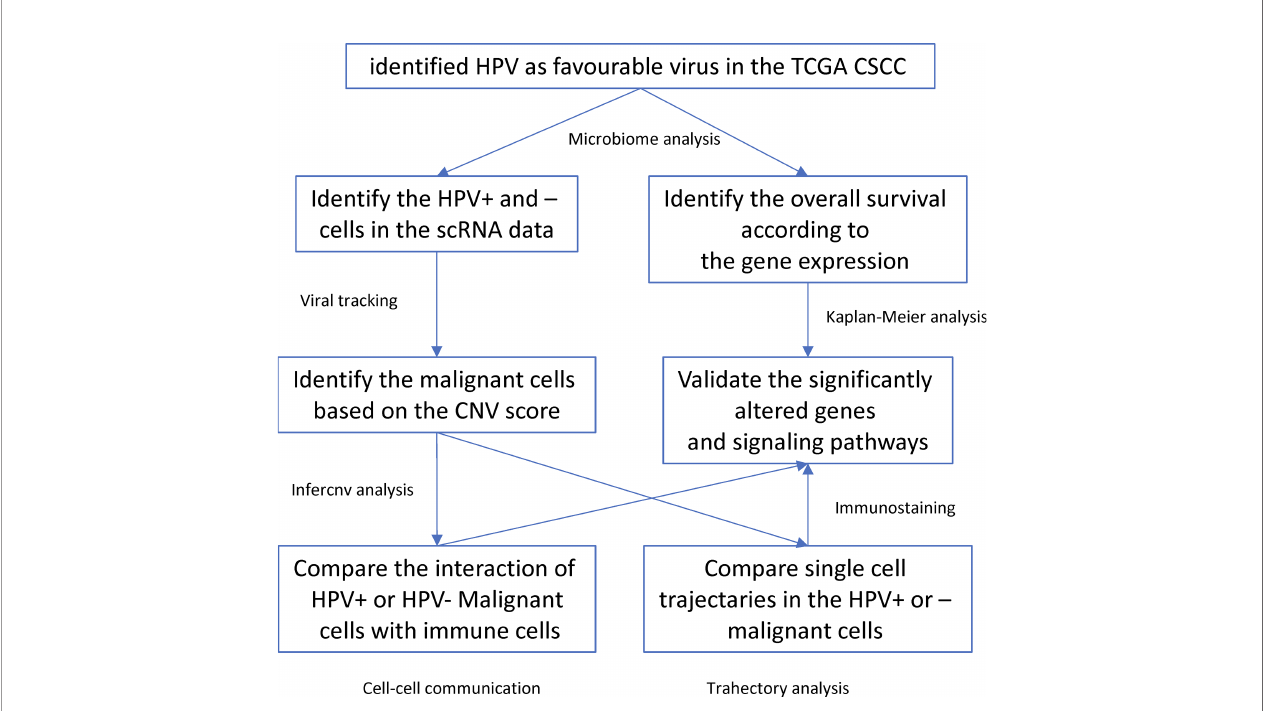
FIGURE 6 | Work fl ow diagram of the current